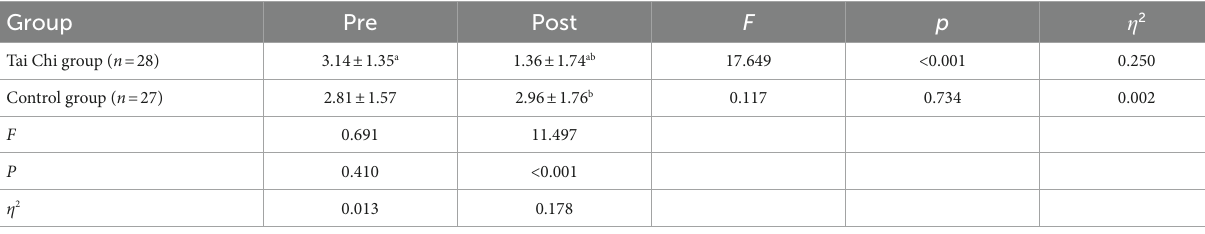
TABLE 4 Results of covariance and repeated measures ANOVA c for valence difference (M ± SD). Group Pre Post F p η 2 Tai Chi group ( n =